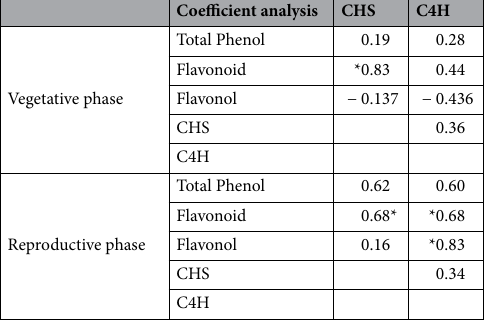
Table 4. Analysis of correlation of the identified phenylpropanoid